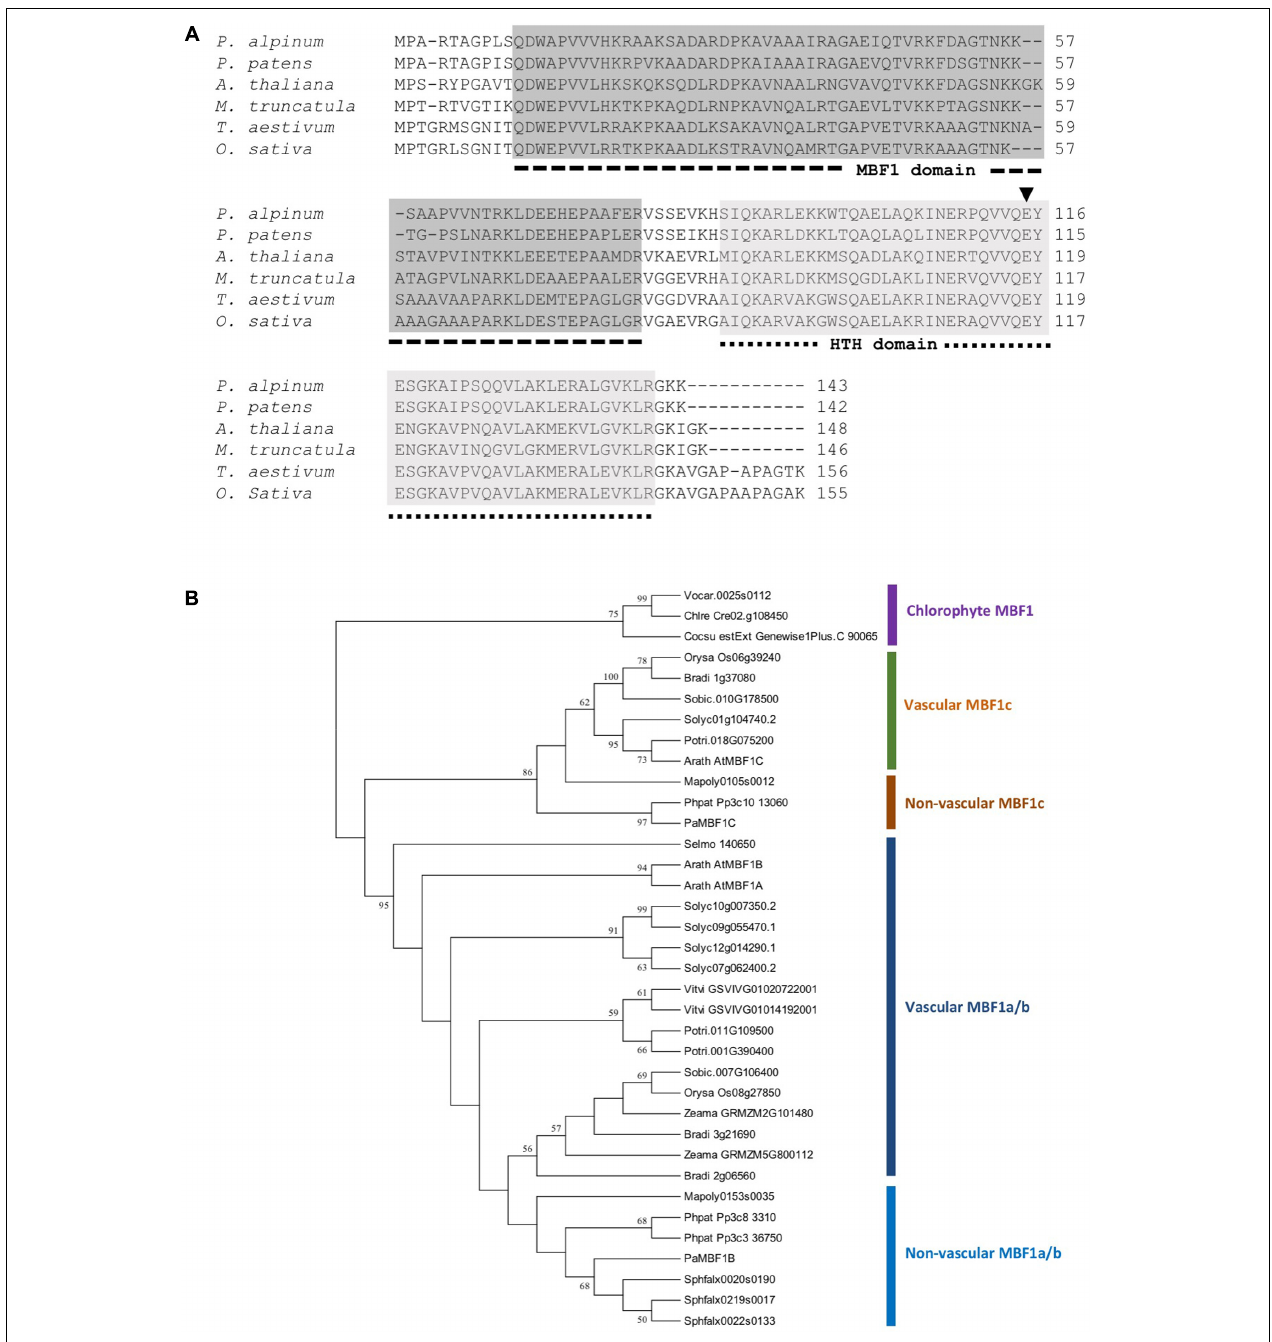
FIGURE 1 | Sequence alignment and phylogenetic analysis of PaMBF1c. (A) Amino acid sequences of PaMBF1c protein (AJG41867) and homologs from Physcomitrella patens (XP_001771731), Oryza sativa (NP_001057974), Medicago truncatula (AES76734), Triticum aestivum (ACU43593), and Arabidopsis thaliana (NP_189093) were used for amino acid sequence alignment. The dotted lines below the sequence alignment indicate multiprotein bridging factor 1 (MBF1) domain and helix-turn-helix (HTH) domain. In the HTH domain, the amino acid residue glutamic acid (E) (arrow head) is conserved among all plant MBF1 proteins. (B) Phylogenetic tree of MBF1 proteins from diverse species. MBF1 proteins from mosses ( Polytrichastrum alpinum ; Phpat, Physcomitrella patens ; Sphfalx, Sphagnum fallax ; Mapoly, Marchantia polymorpha ), Lycophyte (Selmo, Selaginella moellendorffii ), algae (Chlre, Chlamydomonas reinhardtii ; Cocsu, Coccomyxa subellipsoidea ; Vocar, Volvox carteri ), monocots (Zeama, Zea mays ; Bradi, Brachypodium distachyon ; Orysa, Oryza sativa ; Sobic, Sorghum bicolor ), and dicots (Arath, Arabidopsis thaliana ; Vitvi, Vitis vinifera ; Solyc, Solanum lycopersicum ; Potri, Populus trichocarpa ) were included. The phylogenetic tree was constructed using the Neighbor-Joining